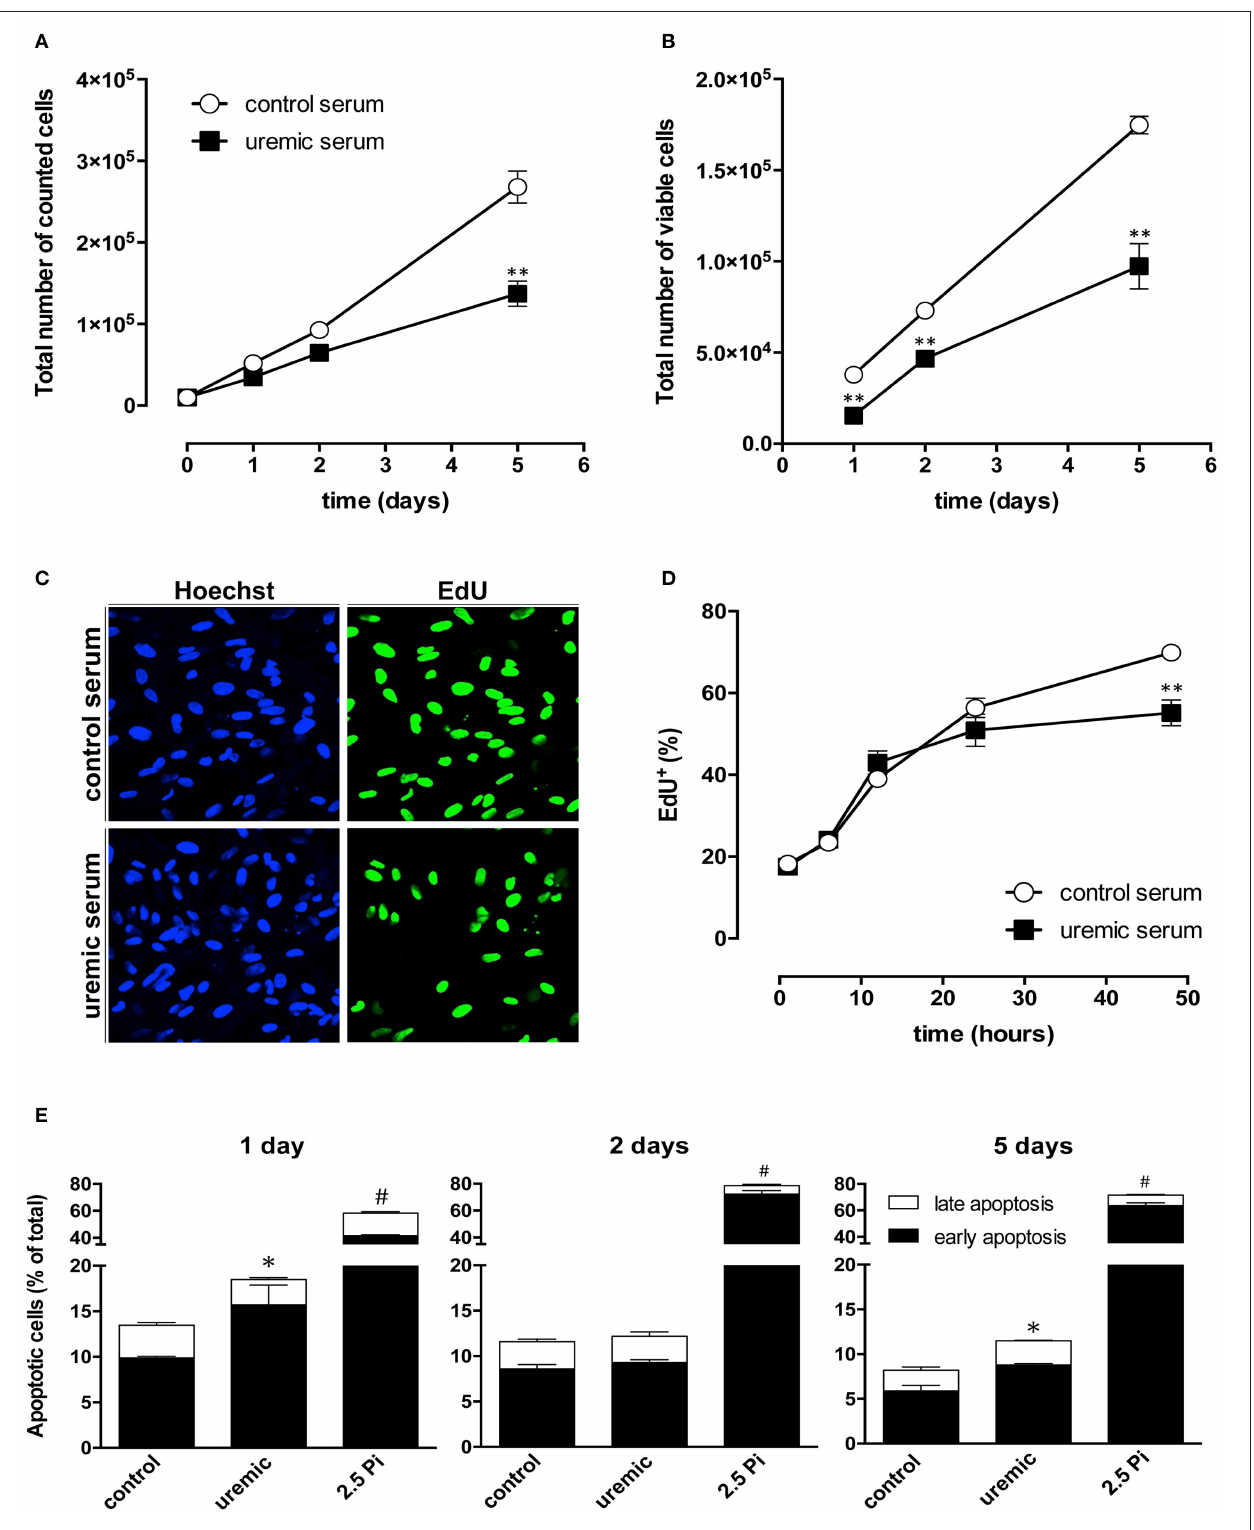
FIGURE 5 | Uremic serum-exposed HASMC show slightly decreased cell proliferation and increased apoptosis. (A) Total number of cells in cultures exposed to control or uremic serum for the indicated amount of time. Bars represent mean ± SE ( N = 3). ( B ) Number of Trypan blue-excluding (viable) cells in cultures exposed to control or uremic serum for the indicated amount of time. Bars represent mean ± SE ( N = 3). (C) HASMC cell proliferation was measured using the EdU incorporation